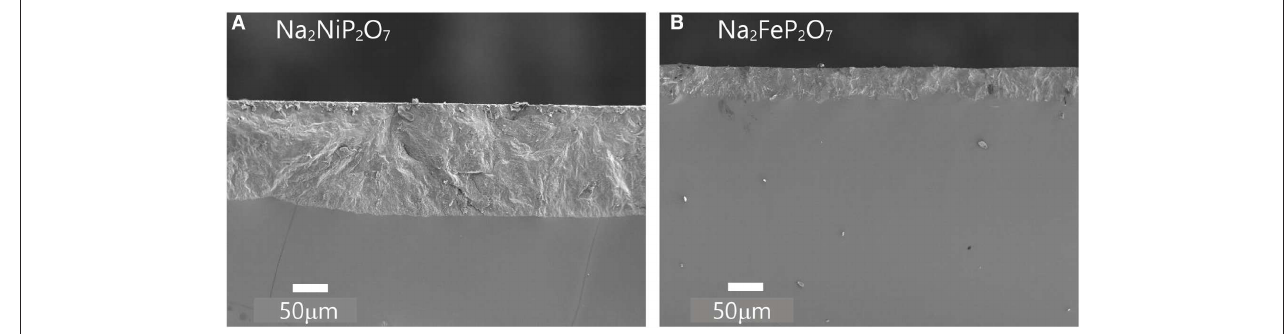
FIGURE 9 | The section SEM image of (A) Na 2 NiP 2 O 7 heat-treated at 500 ◦ C for 3h; (B) Na 2 FeP 2 O 7 heat-treated at 430 ◦ C for 3h.